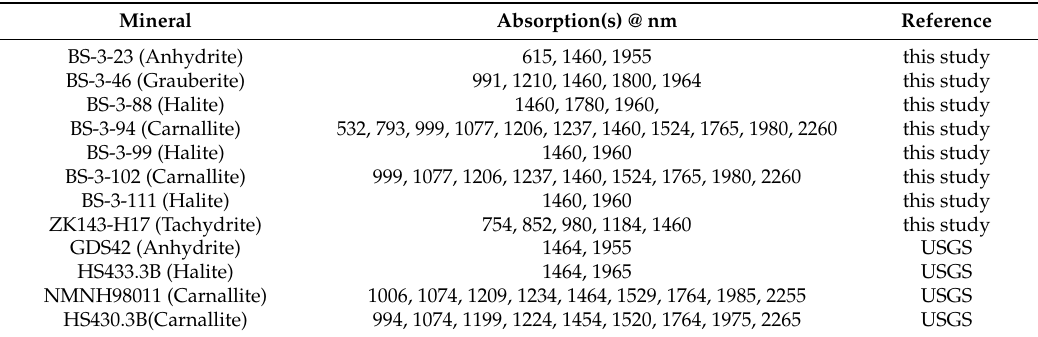
Table 5. Summary of mineral absorption peaks from this study, and reference samples from the USGS spectral